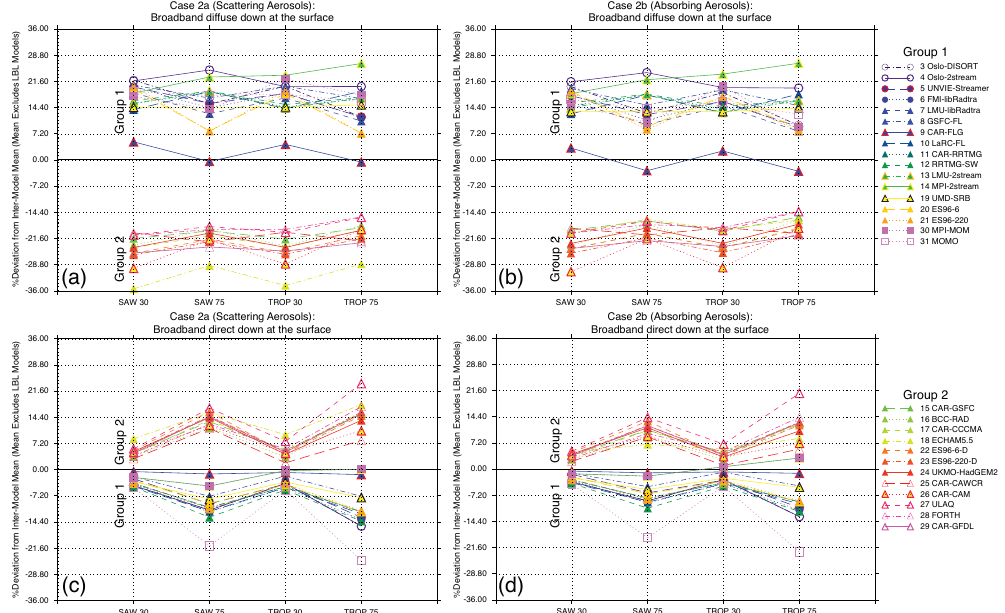
Fig. A3. The same as Fig. A2 except for broadband diffuse flux down at the surface in the Rayleigh atmosphere (Case 1). See Appendix Table A2 for additional statistics.